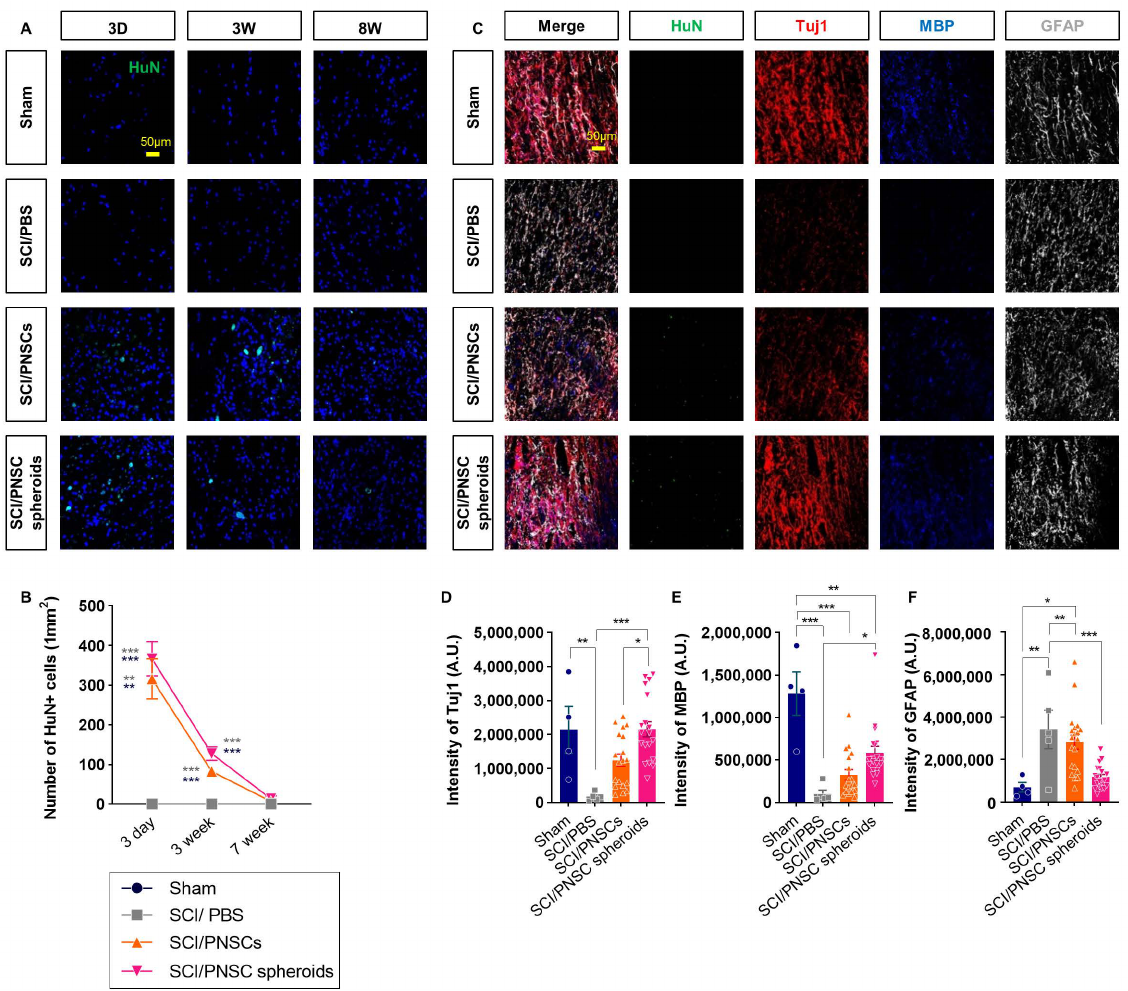
Figure 6. Viability and differentiation of transplanted peripheral nerve-derived stem cells (PNSCs). ( A ) Representative confocal imaging showing DAPI (blue) and anti-HuN (green) staining three days, three weeks, and seven weeks after transplantation. ( B ) Total number of HuN+ with DAPI+ cells per mm 2 . ( C ) Representative confocal imaging showing anti-HuN (green), anti-Tuj1 (red), anti-MBP (blue), and anti-GFAP (white) eight weeks after injury. ( D ) Total Tuj1 staining intensity in the Sham ( n = 4), SCI/PBS ( n = 5), SCI/PNSCs ( n = 19), and SCI/PNSC spheroids ( n = 19) groups. Ordinary one-way ANOVA with Tukey’s multiple comparisons was used for analysis. ( E ) Total MBP staining intensity in all groups. The n numbers and analysis was the same as for Tuj1. ( F ) Total GFAP staining intensity in all groups. The n sizes and analysis were the same as for Tuj1. All data are expressed as mean ± S.E.M.; * p < 0.05, ** p < 0.01, and *** p <